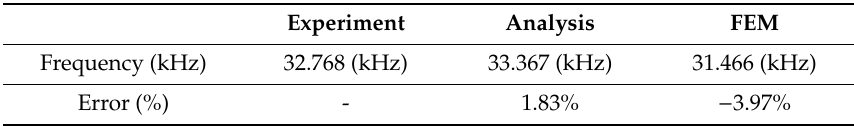
Table 2. Natural frequency of the first in-plane anti-phase mode from experiment, FEM (finite element method), and theoretical